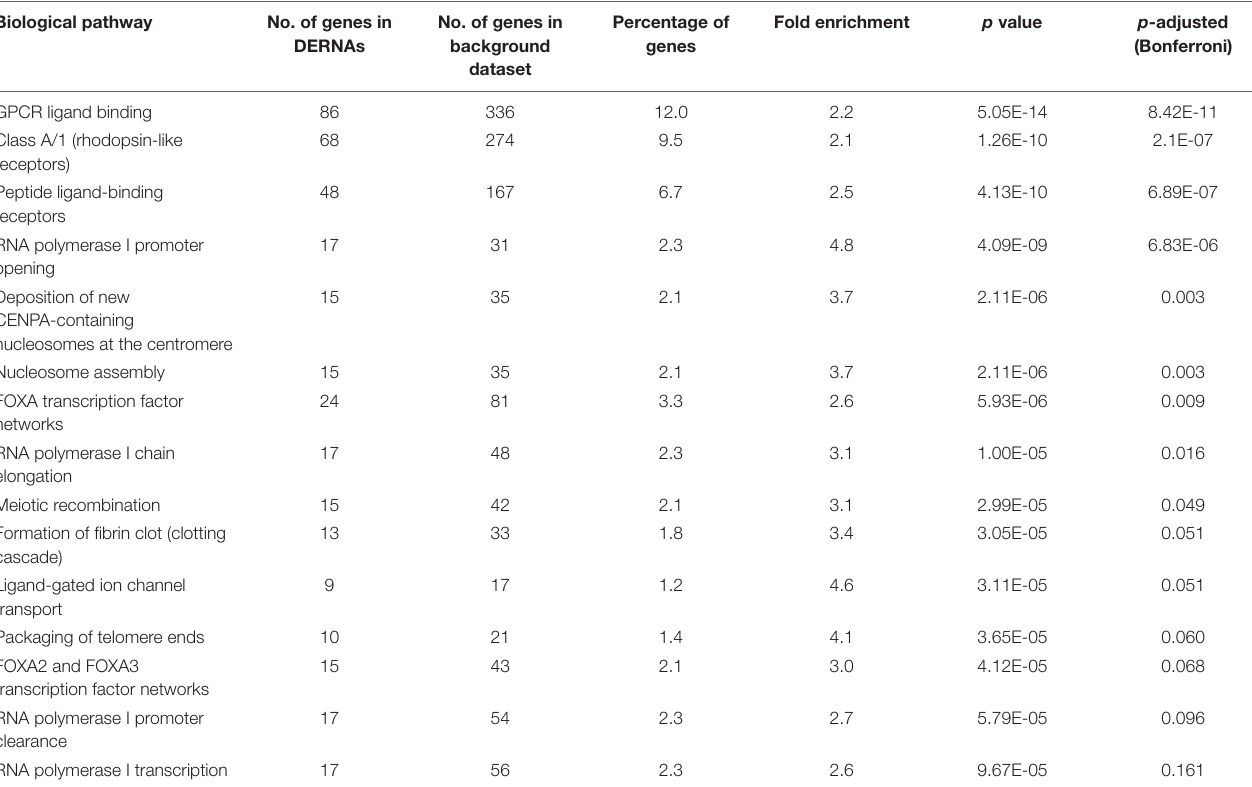
TABLE 1 | Enriched biological pathways and associated genes. Biological pathway No. of genes in